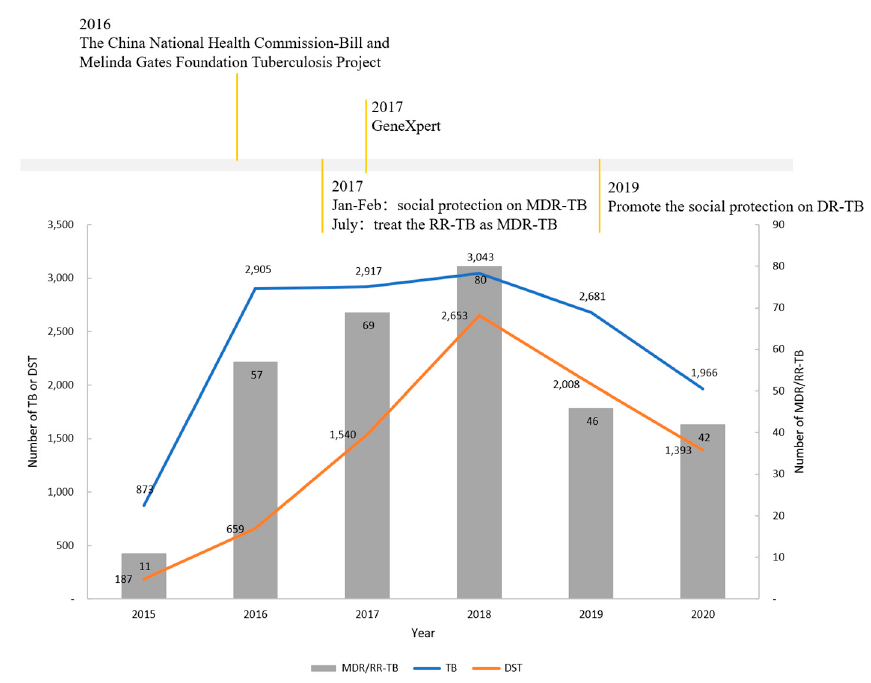
Figure 1. Number of patients diagnosed with MDR/RR-TB (grey), TB (blue), and number of people receiving DST (orange) on a yearly time scale from 1 Sept., 2015 to 30 Sept., 2020.